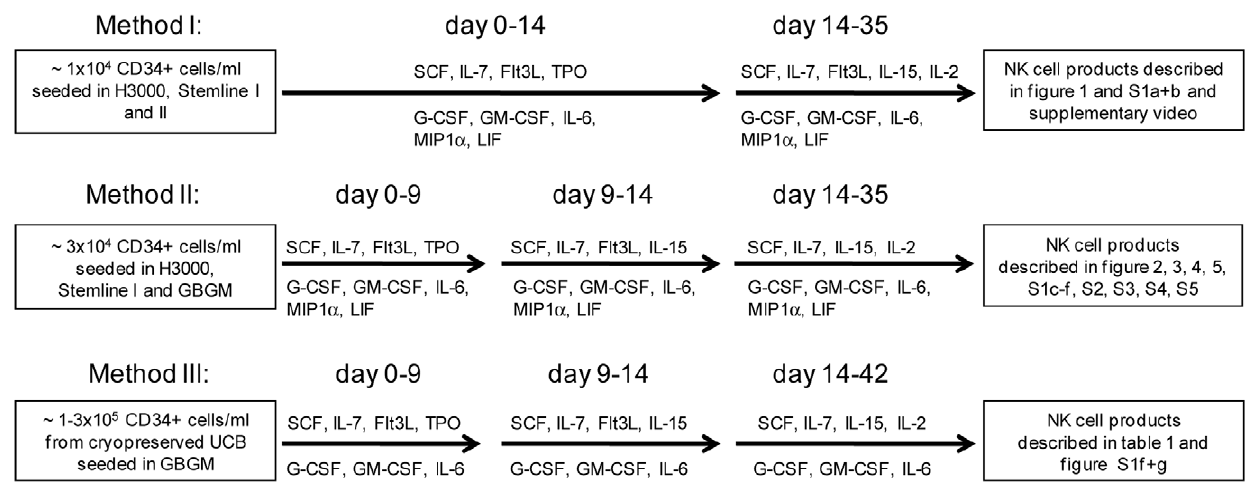
Figure 1. Schematic diagram of the different culture methods used for the ex vivo generation of CD56 + NK cells from cytokine- expanded CD34 + UCB cells. In Method I–III different combinations of cytokines were tested as described in detail in Materials and Methods starting with different numbers of initially seeded CD34 + cells. In Method I and II, NK cells were generated from freshly selected UCB donors and the culture duration was 5 weeks. In Method III, CD34 + cells were used from cryopreserved UCB donors and the culture period was 6 weeks. Finally, the diagram depicts which NK products were used and displayed as results in figures and supplemental material.